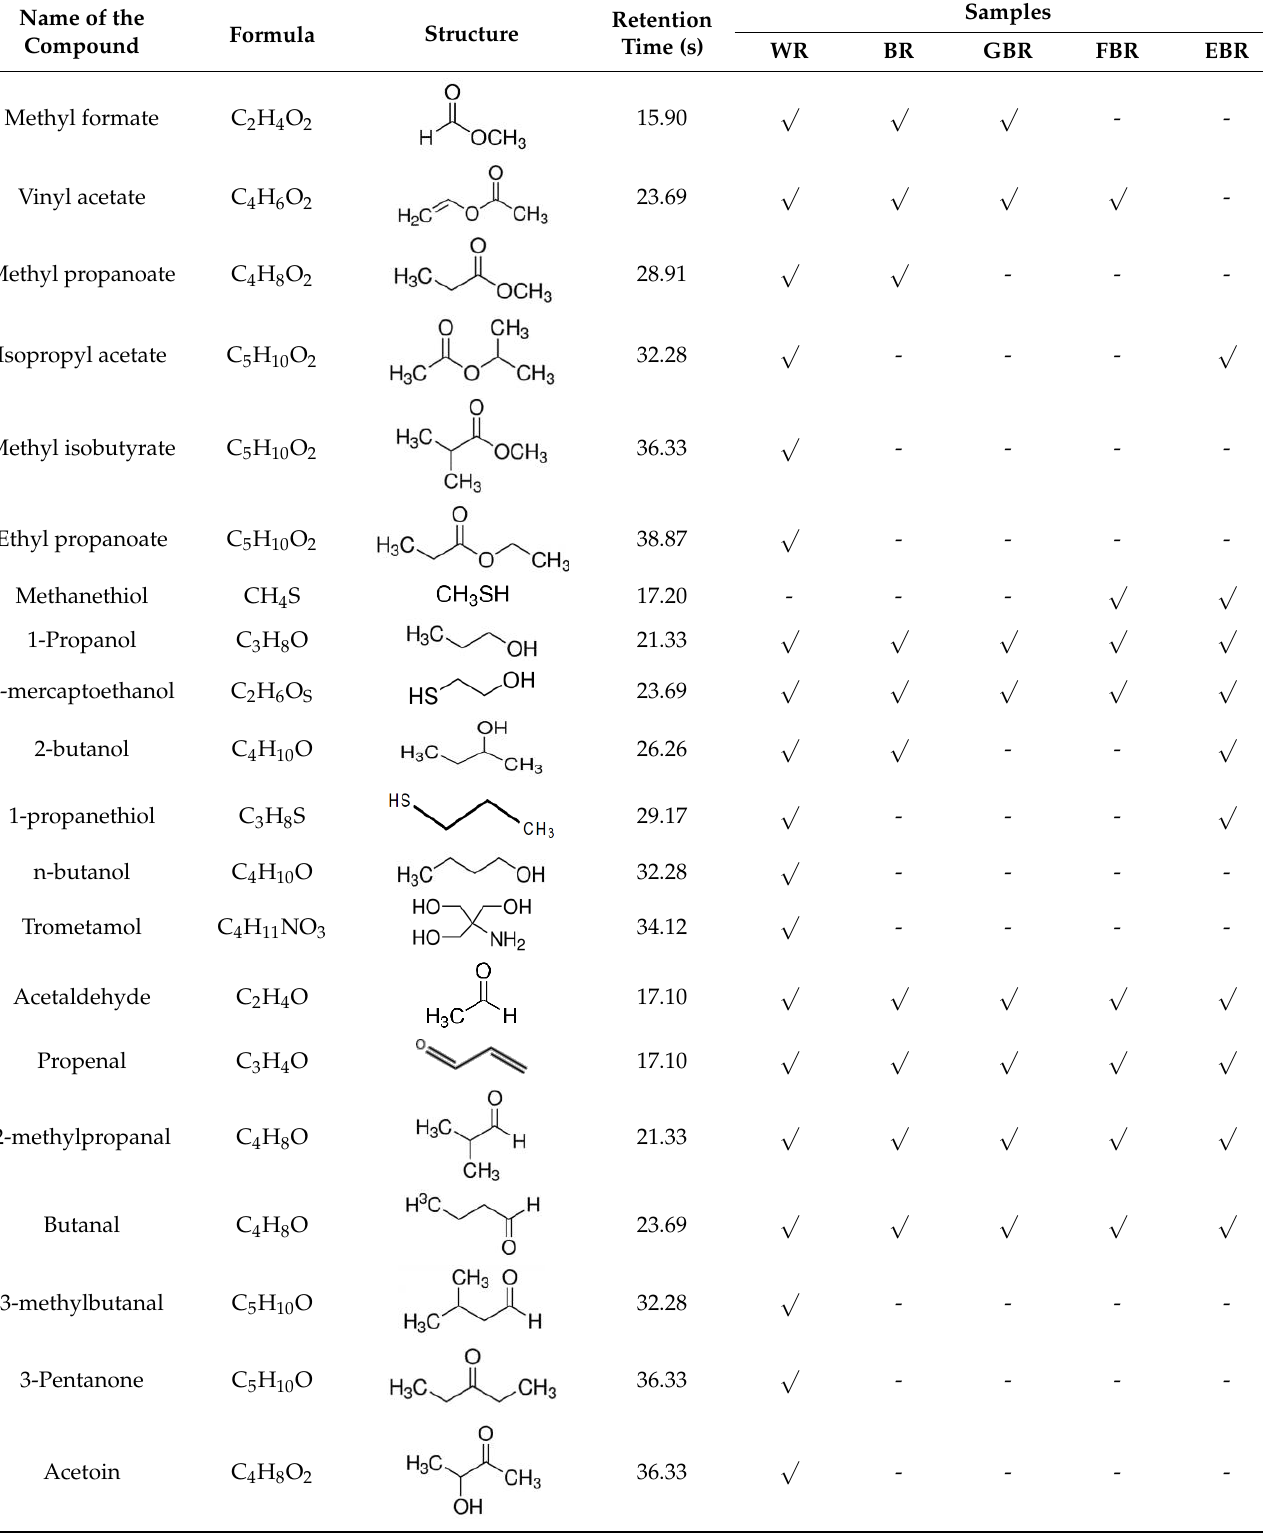
Table 5. Key volatile flavor compounds of different brown rice products. Name of the Com- pound